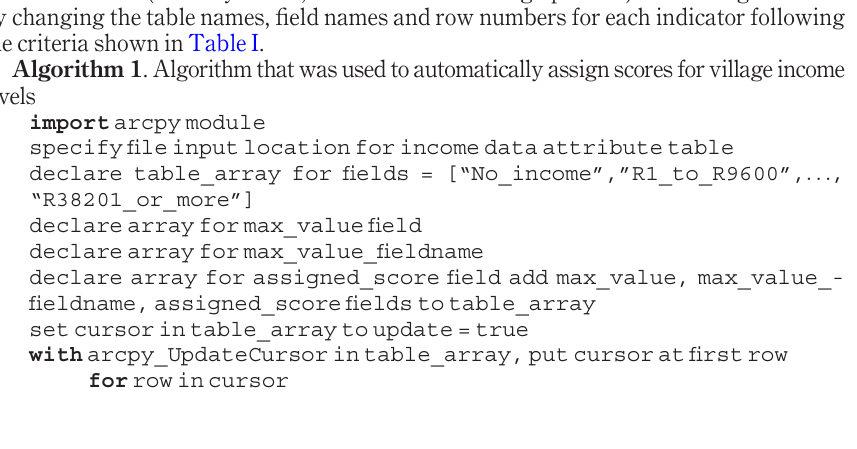
Algorithm 1 . Algorithm that was used to automatically assign scores for village income levels import arcpy module